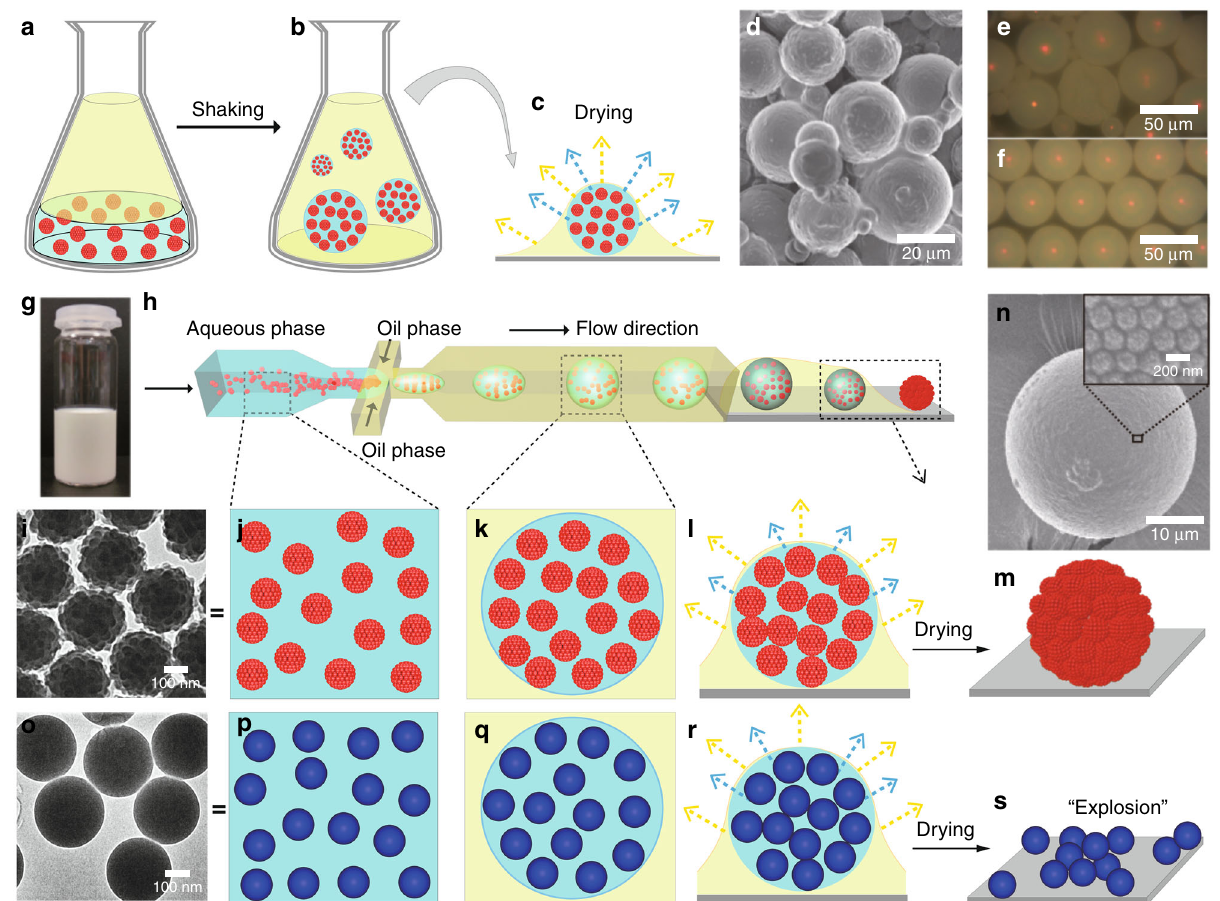
Fig. 3 Difference in colloidal stability of emulsion droplets made of either raspberry or smooth particles. a A ∼ 20 w% dispersion of raspberries is mixed in 1:3 parts with fl uorinert oil FC40 containing 0.01 w% surfactant FX171 (Sigma Aldrich) ( b ), vigorously mixed ( c ) and then left to dry. d SEM image of